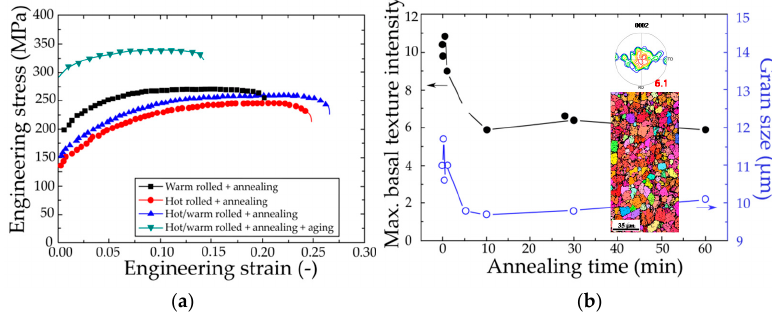
Figure 15. ( a ) Stress–strain curves of the rolled and heat-treated ZK60 alloys [61] and ( b ) the maximum intensity of basal texture and grain size of the hot/warm rolled alloy relative to the annealing time [61]. The inset in (b) shows the (0002) pole figure and EBSD inverse pole figure map of the hot/warm rolled plus annealed alloy. Reproduced with permission from Kim et al., Mater. Sci. Eng. A ; published by Elsevier, 2014.